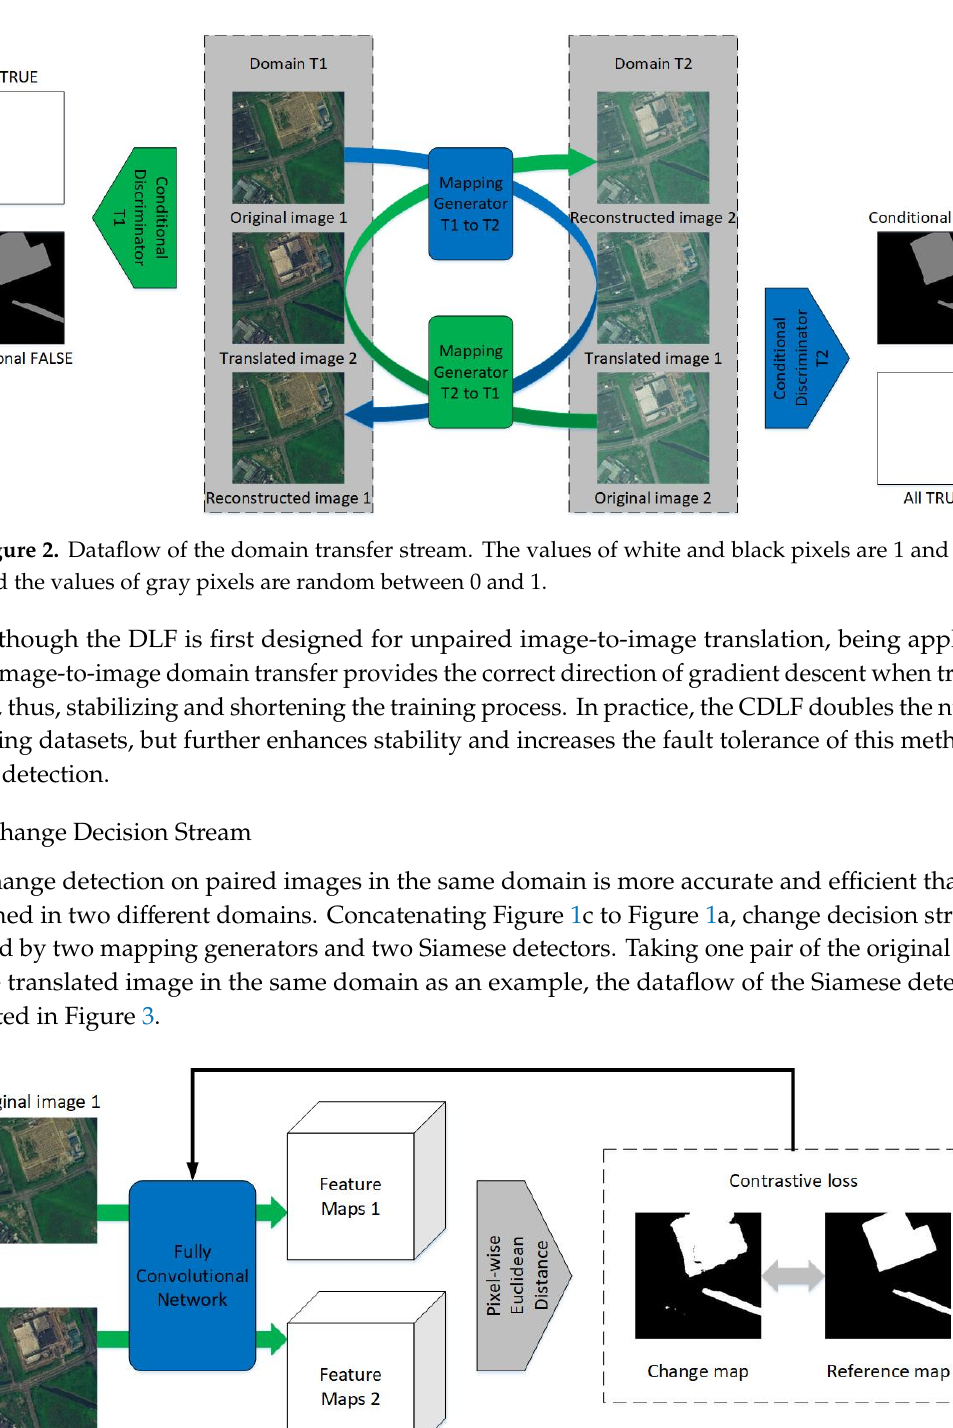
Figure 3. Dataflow of the Siamese detector. The changed pixels are white, while the unchanged pixels are black.